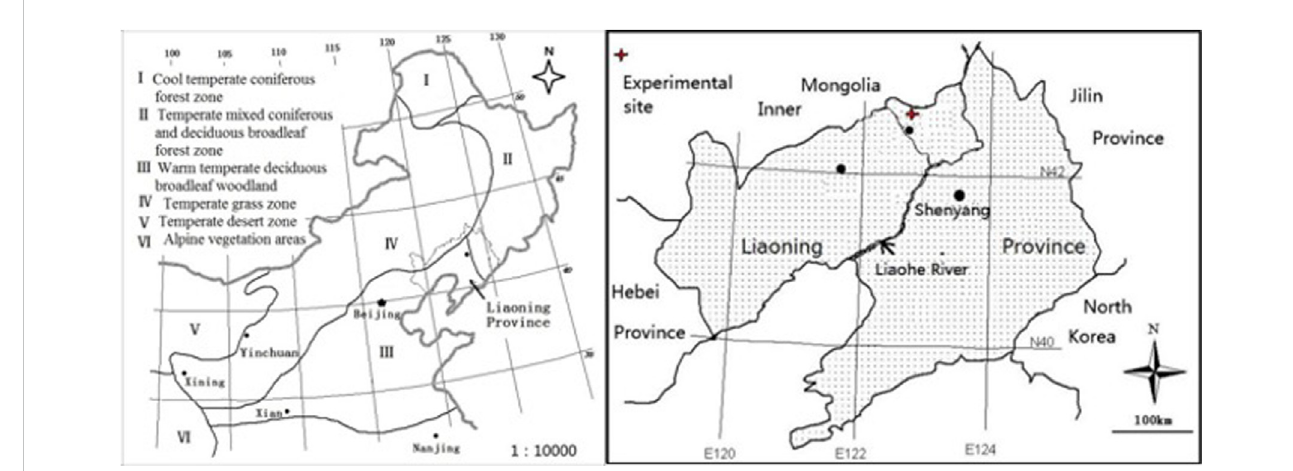
FIGURE 1 Basic information of test site, the red cross in the fi gure is the location of the test site.